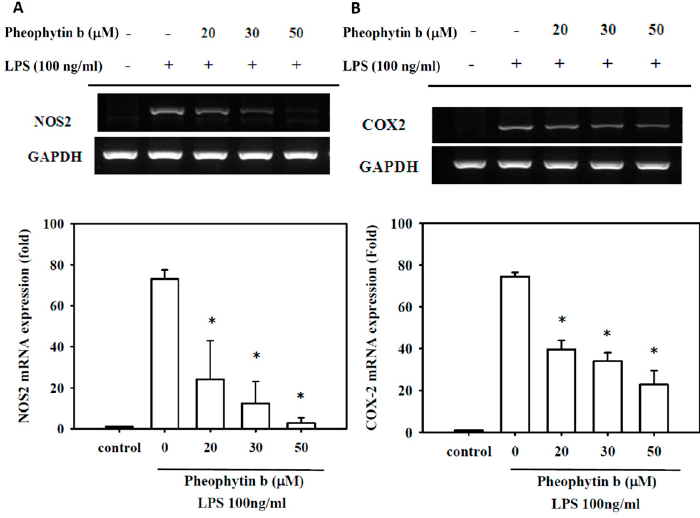
Figure 4. Pheophytin-b suppressed NOS2 and COX-2 mRNA expression levels in LPS-stimulated RAW 264.7 cells. Cells were pre-treated with the indicated concentrations of pheophytin-b for 30 min and stimulated with LPS for 3 h. NOS2 ( A ) and COX-2 ( B ) mRNA levels were determined by QRT-PCR analysis, quantified, and normalized to those of the control group. Bottom panels show the fold-change compared to the control group (without LPS stimulation). Expression of GAPDH was analyzed as a control to ensure equal loading. * p < 0.05 vs. the cells treated with LPS alone (by Student’s t -test, n = 3).